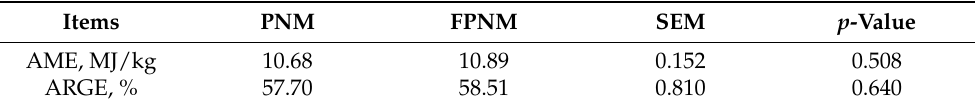
Table 7. Apparent metabolizable energy and apparent retention of gross energy in PNM and